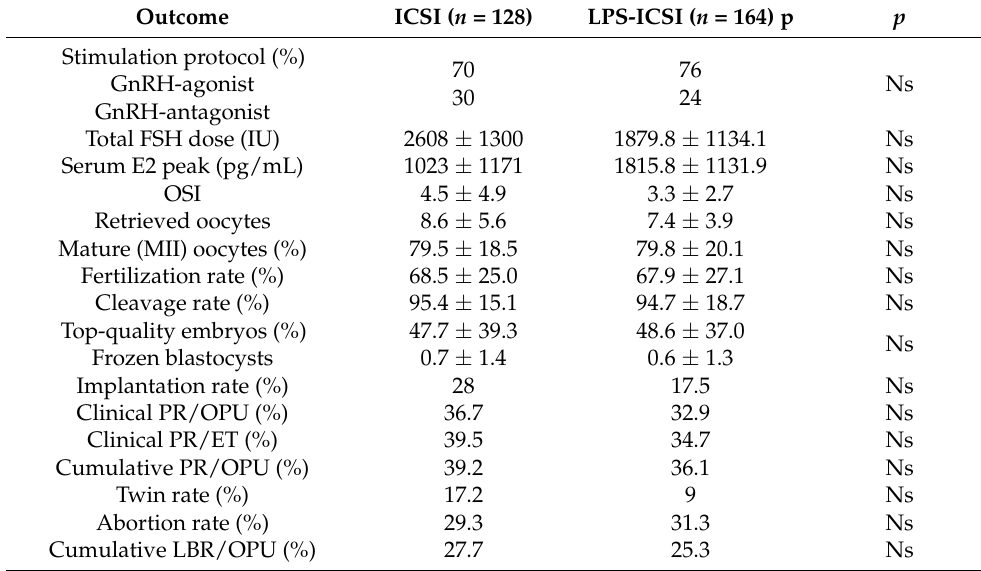
Table 4. Outcome of ICSI in patients with ovarian endometrioma ( n = 128) or patients previously operated on by having their endometrioma laparoscopically removed before ICSI ( n = 164). ICSI was performed in case of severe male factor. No statistically significant difference in the baseline clinical features was observed between